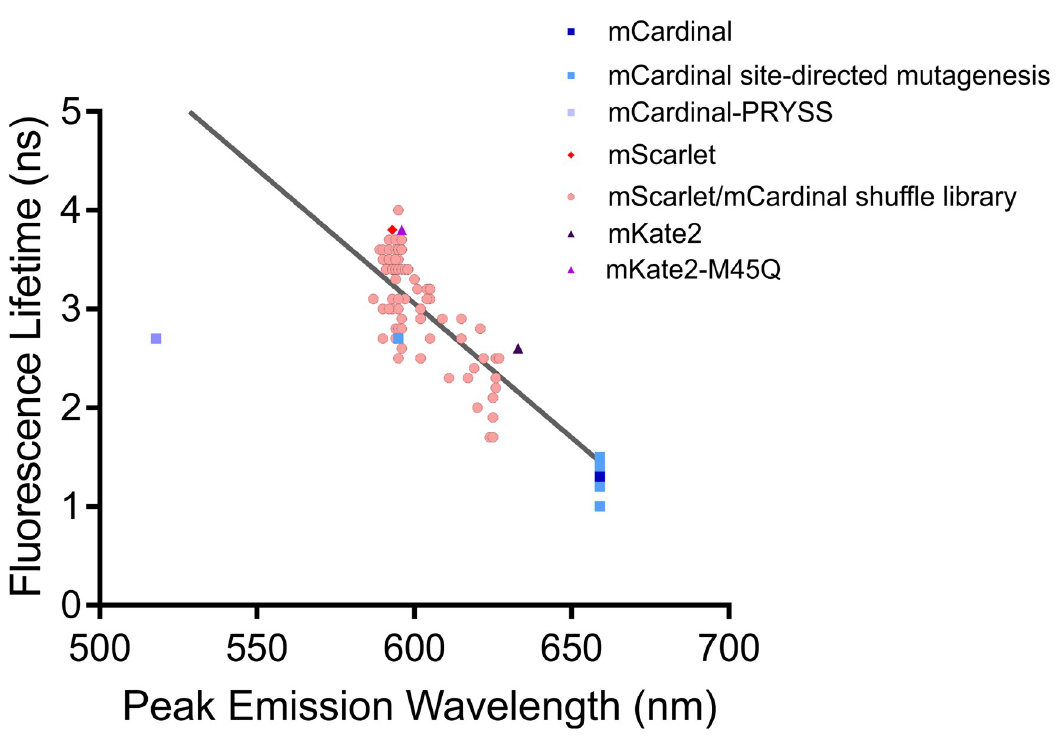
Fig 2. Fluorescence lifetime plotted against peak emission wavelength for all unique fluorescent proteins generated either by site-directed mutagenesis or from the mScarlet/mCardinal shuffle library.